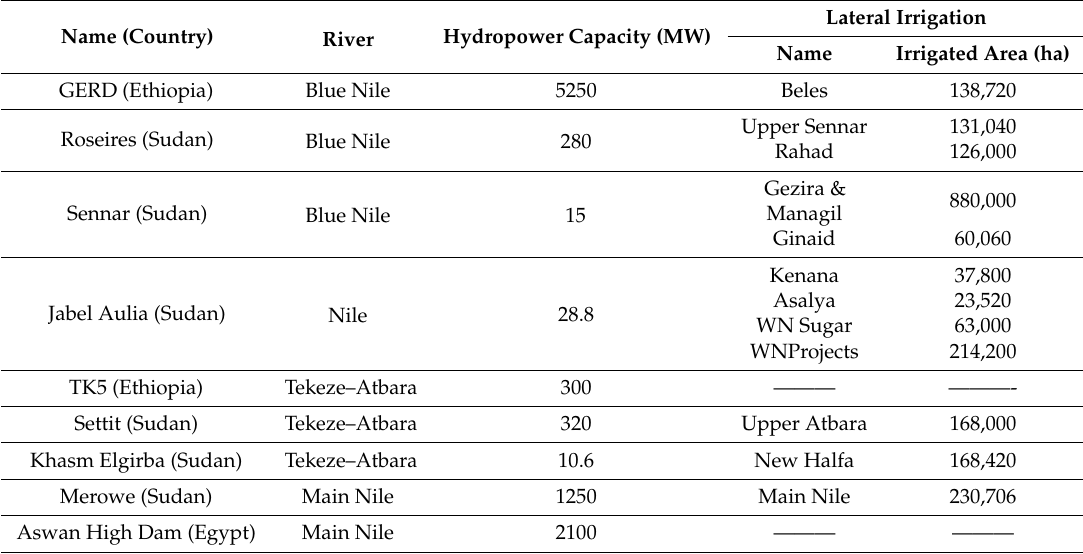
Table 1. Eastern Nile hydropower and irrigation systems included in the